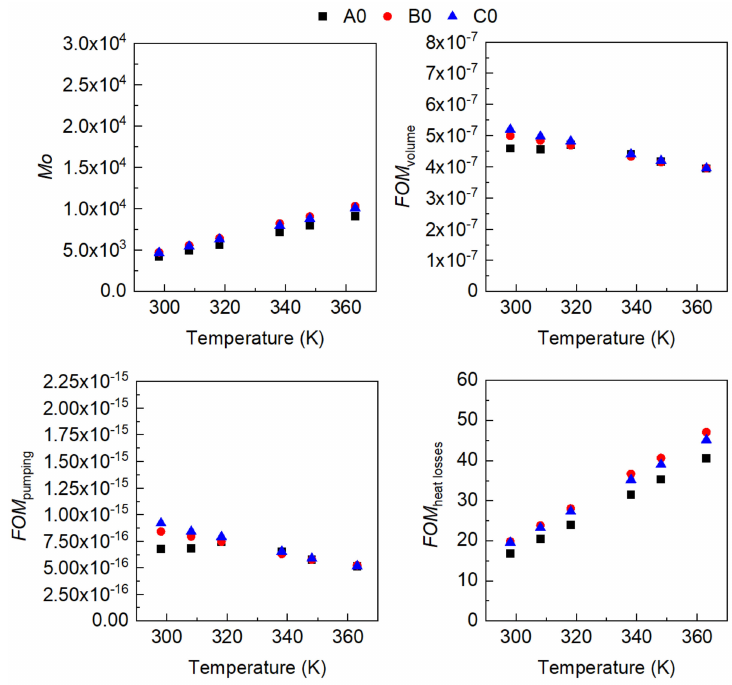
Figure 3. Figures-of-merit (FOM) of the fresh ATFs (A0, B0 and